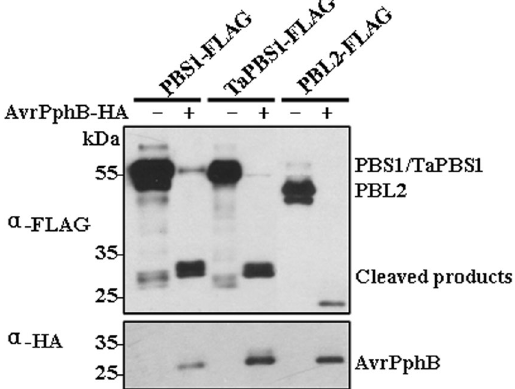
Figure 2. Cleavage of TaPBS1 by AvrPphB in Arabidopsis protoplasts. TaPBS1 could be cleaved by AvrPphB. FLAG-tagged PBS1, TaPBS1, or PBL2 was expressed together with AvrPphB-HA in Arabidopsis protoplasts. Protein cleavage was detected by Western blot analysis with an anti-FLAG antibody. AvrPphB-HA was detected by Western blot analysis with an anti-HA